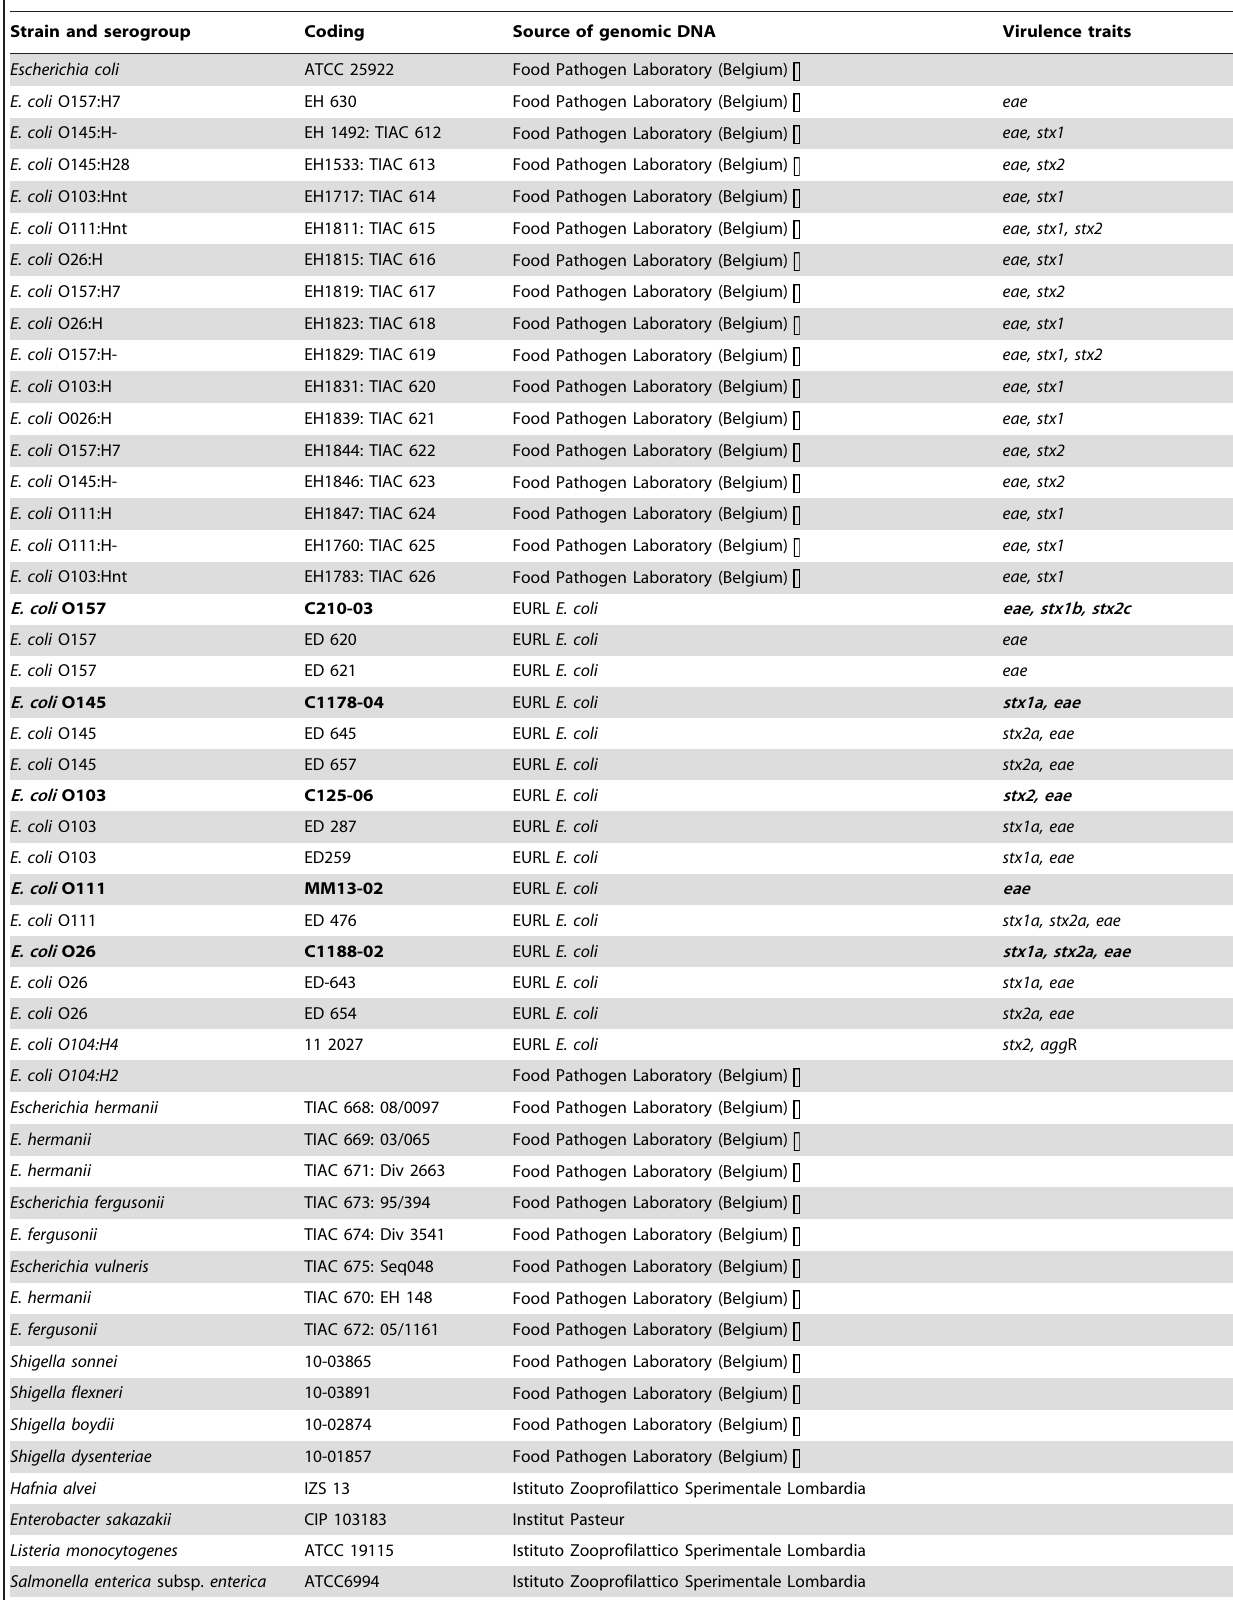
Table 2. Strains used in the